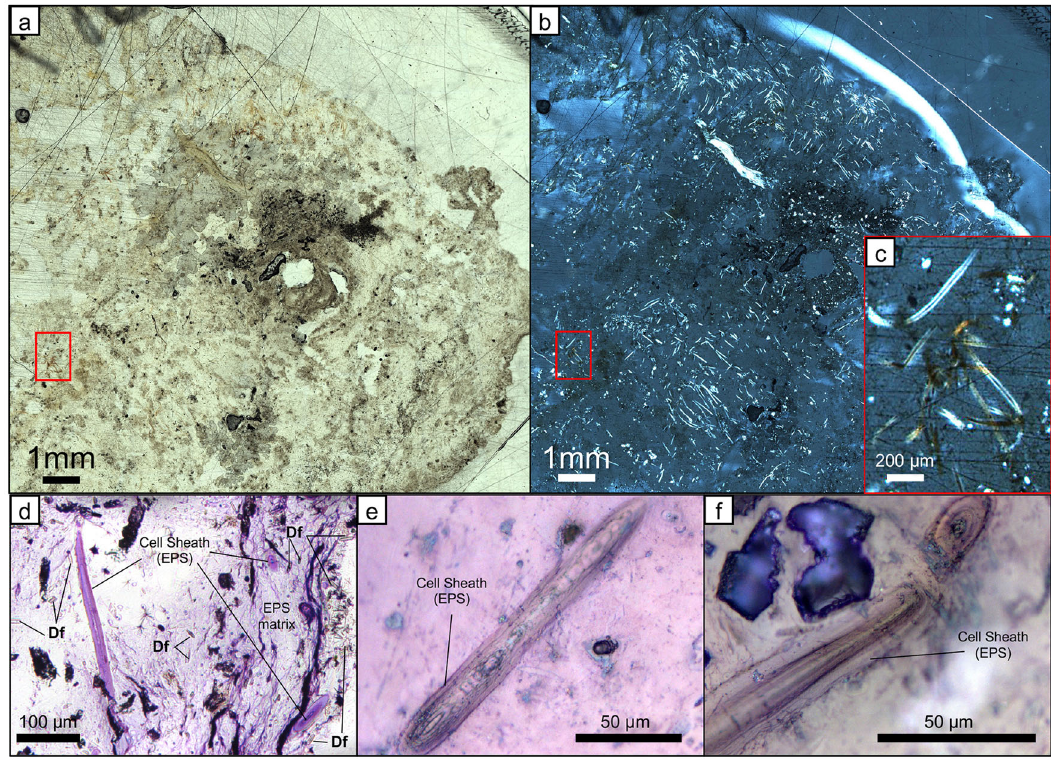
Fig. 2 Optical micrographs showing fi lamentous cyanobacteria encased in Mg-clay. a Sample in plane-polarized light; fi laments dif fi cult to discern, b same sample image shown in cross-polarized light; fi laments are highlighted by fi rst-order birefringence colors, c higher resolution image from red box in ( a , b ) showing detail of fi lamentous cyanobacterial cells (from 12 Fig. 6b), d – f Thin section stained with crystal-violet and shown in plane-polarized light with the stain highlighting biomass; diatom frustules ‘ Df ’ are abundant throughout the sample as shown in ( d